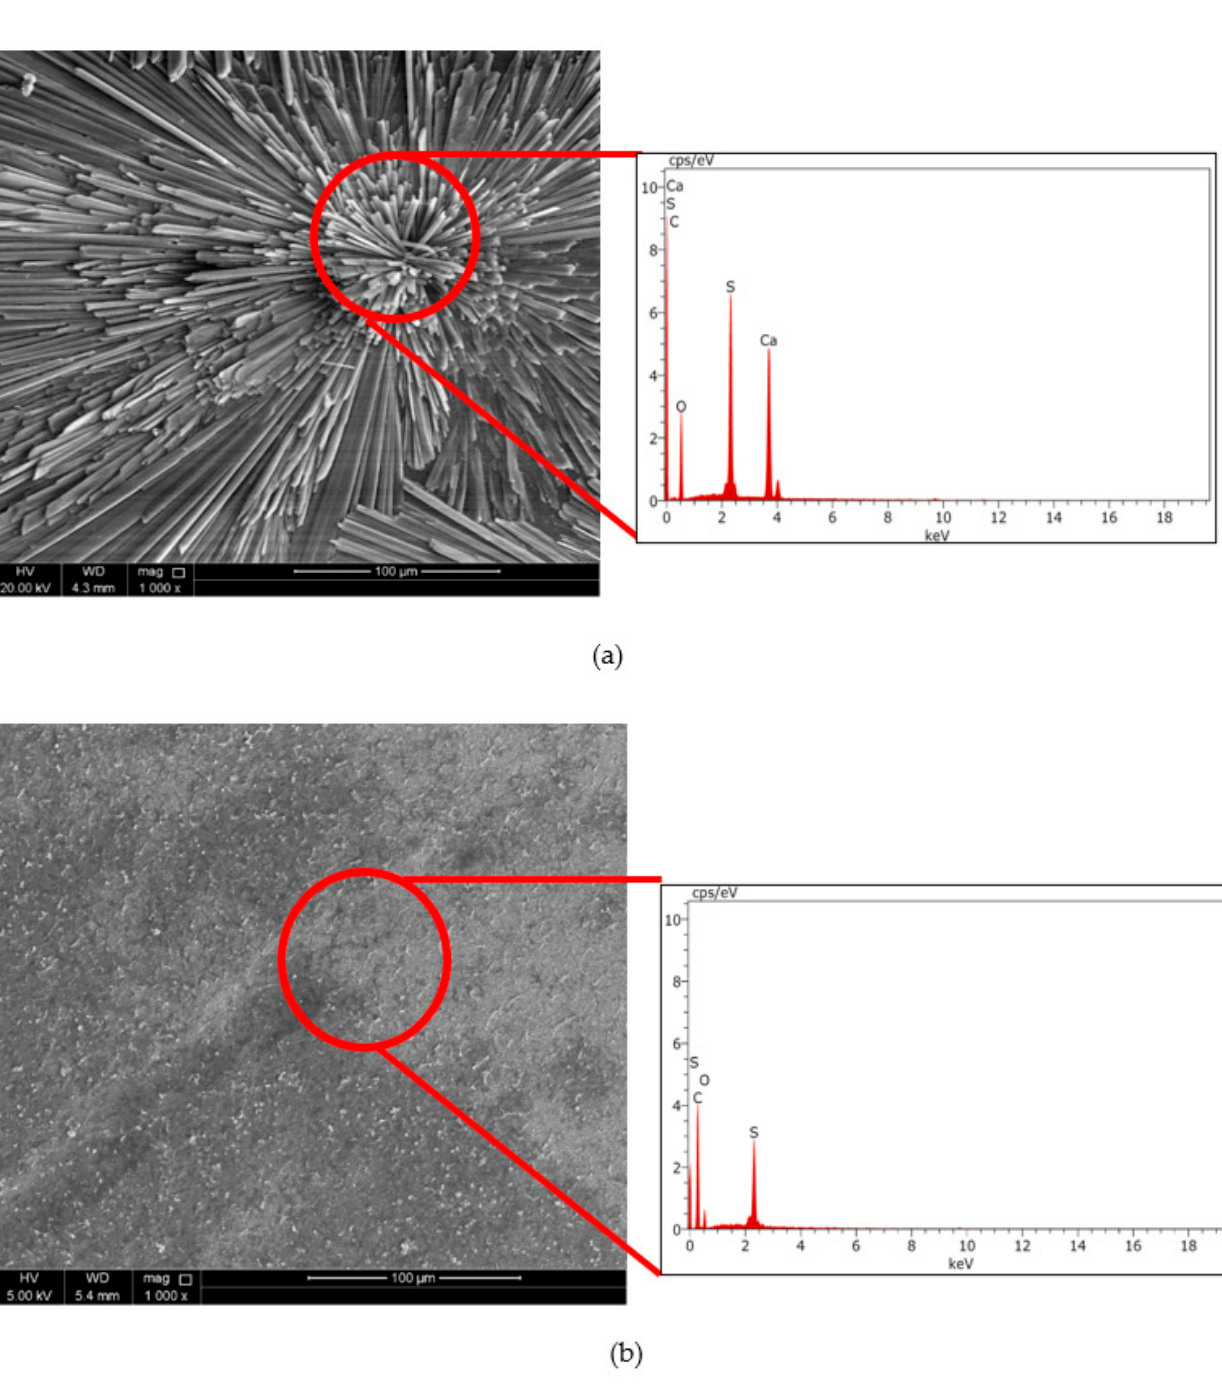
Figure 12. SEM-EDX characterization of the fouling layer ( a ) RO membrane; ( b ) PAA-GO@RO mem-